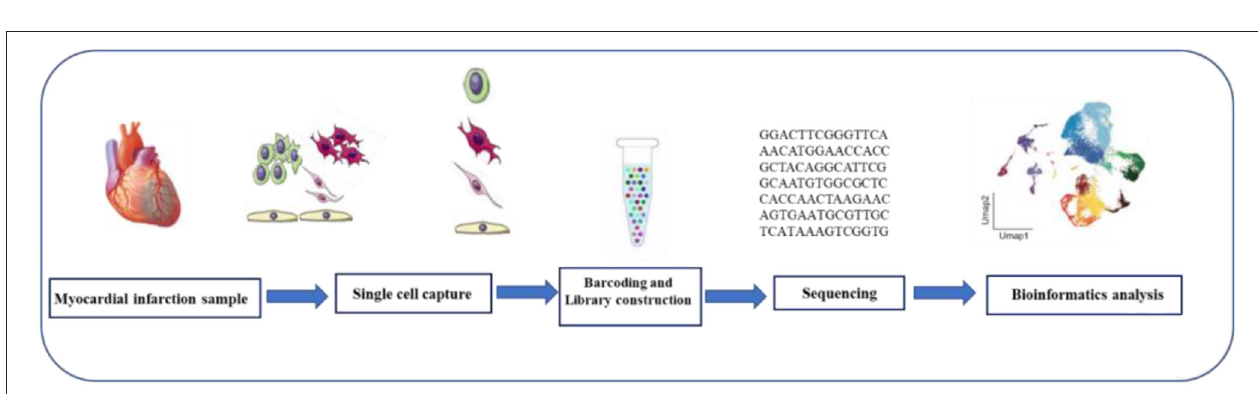
discussed the CMs from failing and non-failing mammalian hearts, revealing the heterogeneity of the in vivo myocardial stress-gene response. The study noted distinct sub-populations of CMs and uncovered gene regulatory networks specific for each sub-population, displaying specific sub-group upregulation of cell cycle, and de-differentiation genes in the disease stress response. The study identified long intergenic non-coding